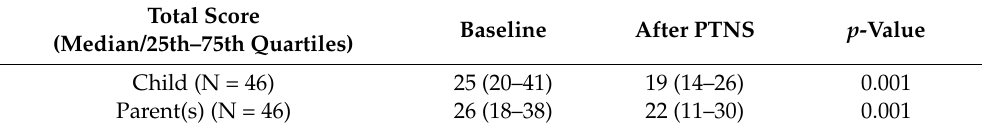
Table 2. Disease-specific quality of life on the pediatric incontinence questionnaire (PIN-Q).